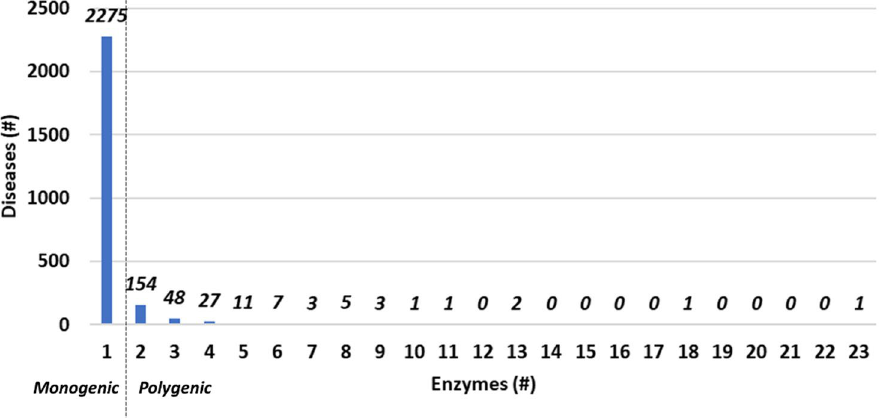
Figure 1. Distribution of diseases according to the number of enzymes they are associated to. #: number of. The number of diseases is reported at the top of each bar. 2275 diseases are associated to only one enzyme. Out of these, 300 are associated to other, non-enzyme, proteins (data not shown). The tail of the distribution comprises one disease (“intellectual disability”, MONDO:0,001,071) associated with 23 enzymes and one disease (“colorectal cancer”, MONDO: 0,005,575) associated with 18 enzymes.